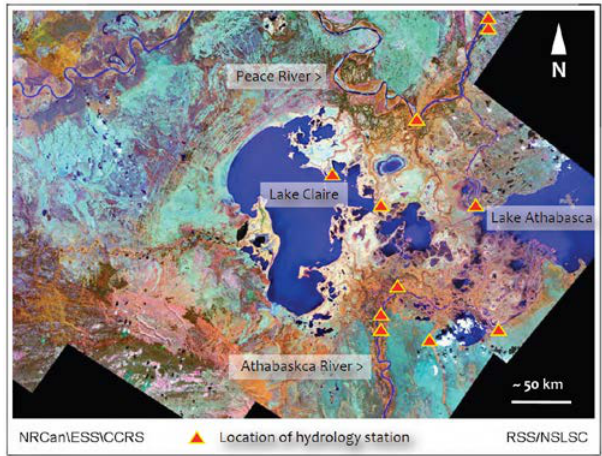
Figure 1.Satellite image map of the Peace-Atahabasca Delta (PAD) study area, indicating land cover characteristics and location of hydrology stations for in-situ data collection.